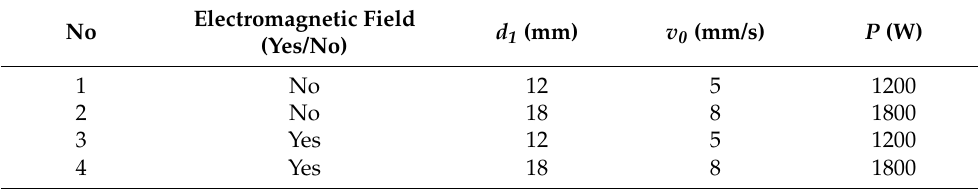
Table 4. Process